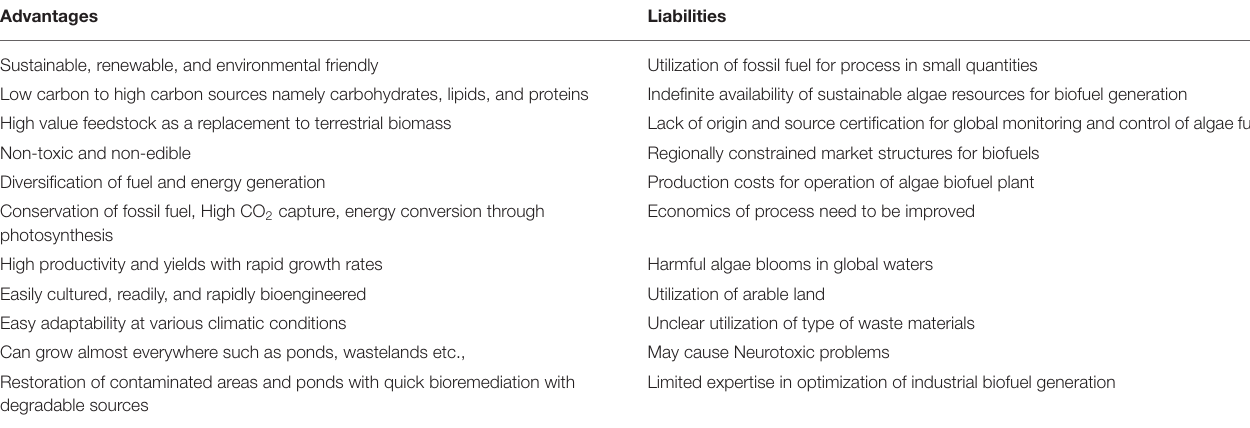
TABLE 1 | Diversified advantages and liabilities of algae based biofuels systems. Advantages Liabilities